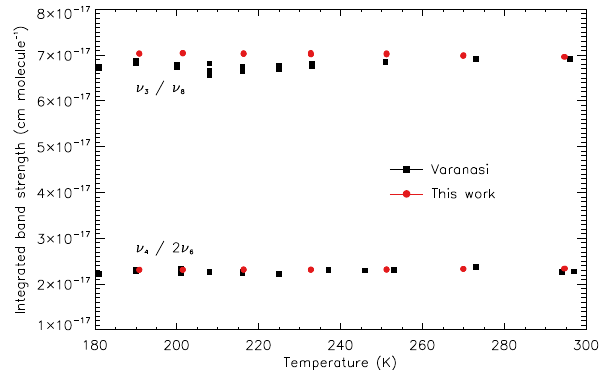
Figure 2. A plot of integrated band strength vs. temperature for each of the datasets over the wavenumber ranges 760–860cm − 1 (principally the ν 4 and 2 ν 6 bands; bottom) and 1070–1195cm − 1 (principally the ν 3 and ν 8 bands; top). The Varanasi data at each temperature display a small spread in values, with a good deal more scatter in the ν 3 / ν 8 band strengths, likely due to some systematic error in the